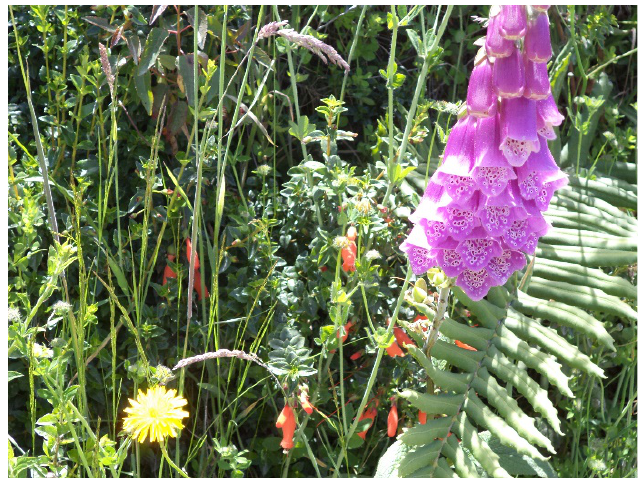
Figure 3: Colorful flowers observed at the roadside.